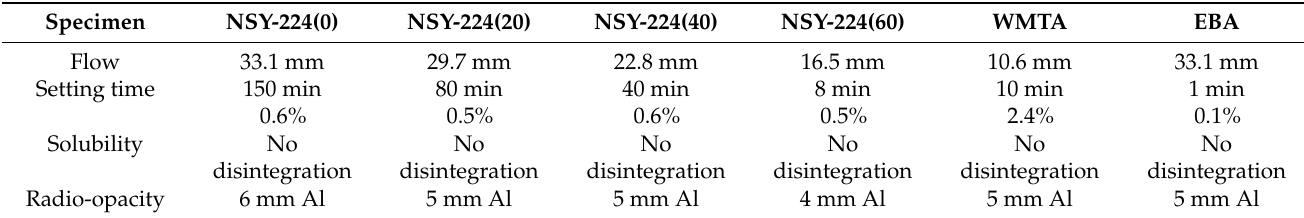
Table 3. Evaluation of the cement specimens based on ISO method.